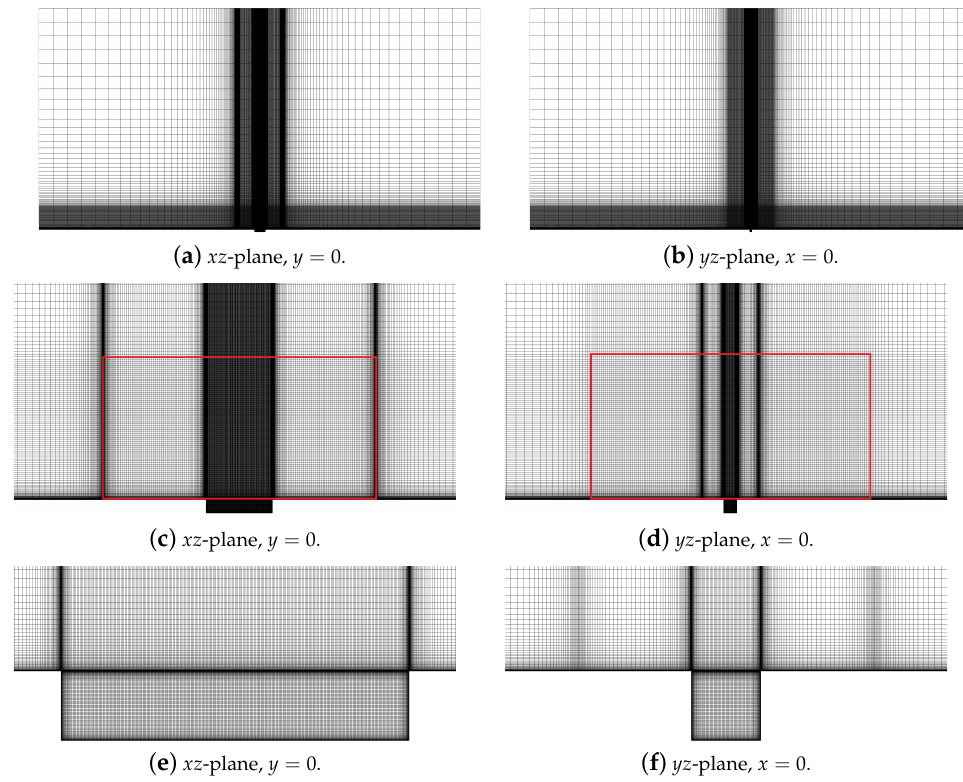
Figure 6. Cross-sectional planes of the grid for the simplified geometry. ( a , b ) Whole computational domain. ( c , d ) Density box region, marked with the red lines. ( e , f ) Cavity